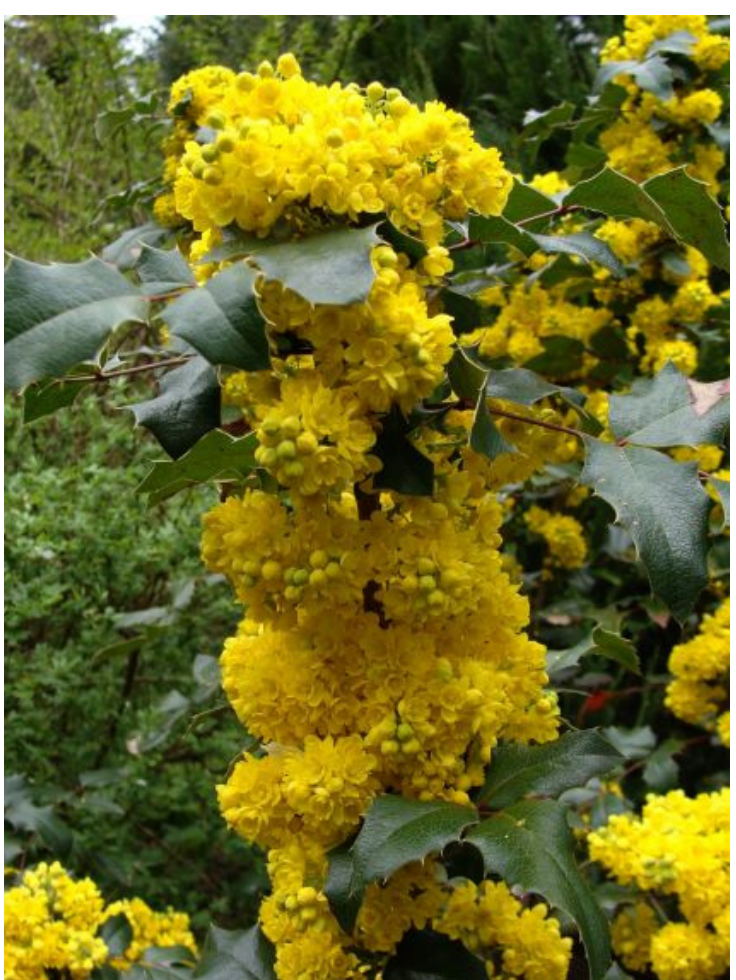
Figure 2. Photograph of Mahonia aquifolium under flowering. (The photo comes from the archives of the Botanical Garden of Maria Curie-Skłodowska University in Lublin (Poland)). The quantitative determination of selected isoquinoline alkaloids in plant extracts were performed in the same chromatographic conditions. Examples of obtained chromatograms are presented in Figures